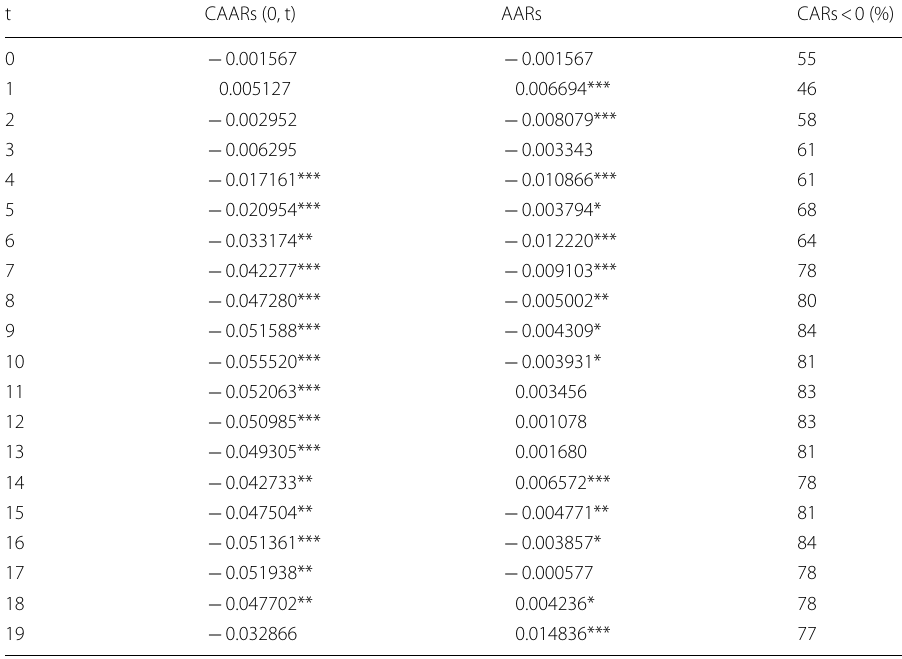
CAARs represent the cumulative average abnormal returns. AARs denote the average abnormal returns. t statistics in parentheses. * p < 0.1; ** p < 0.05; *** p <